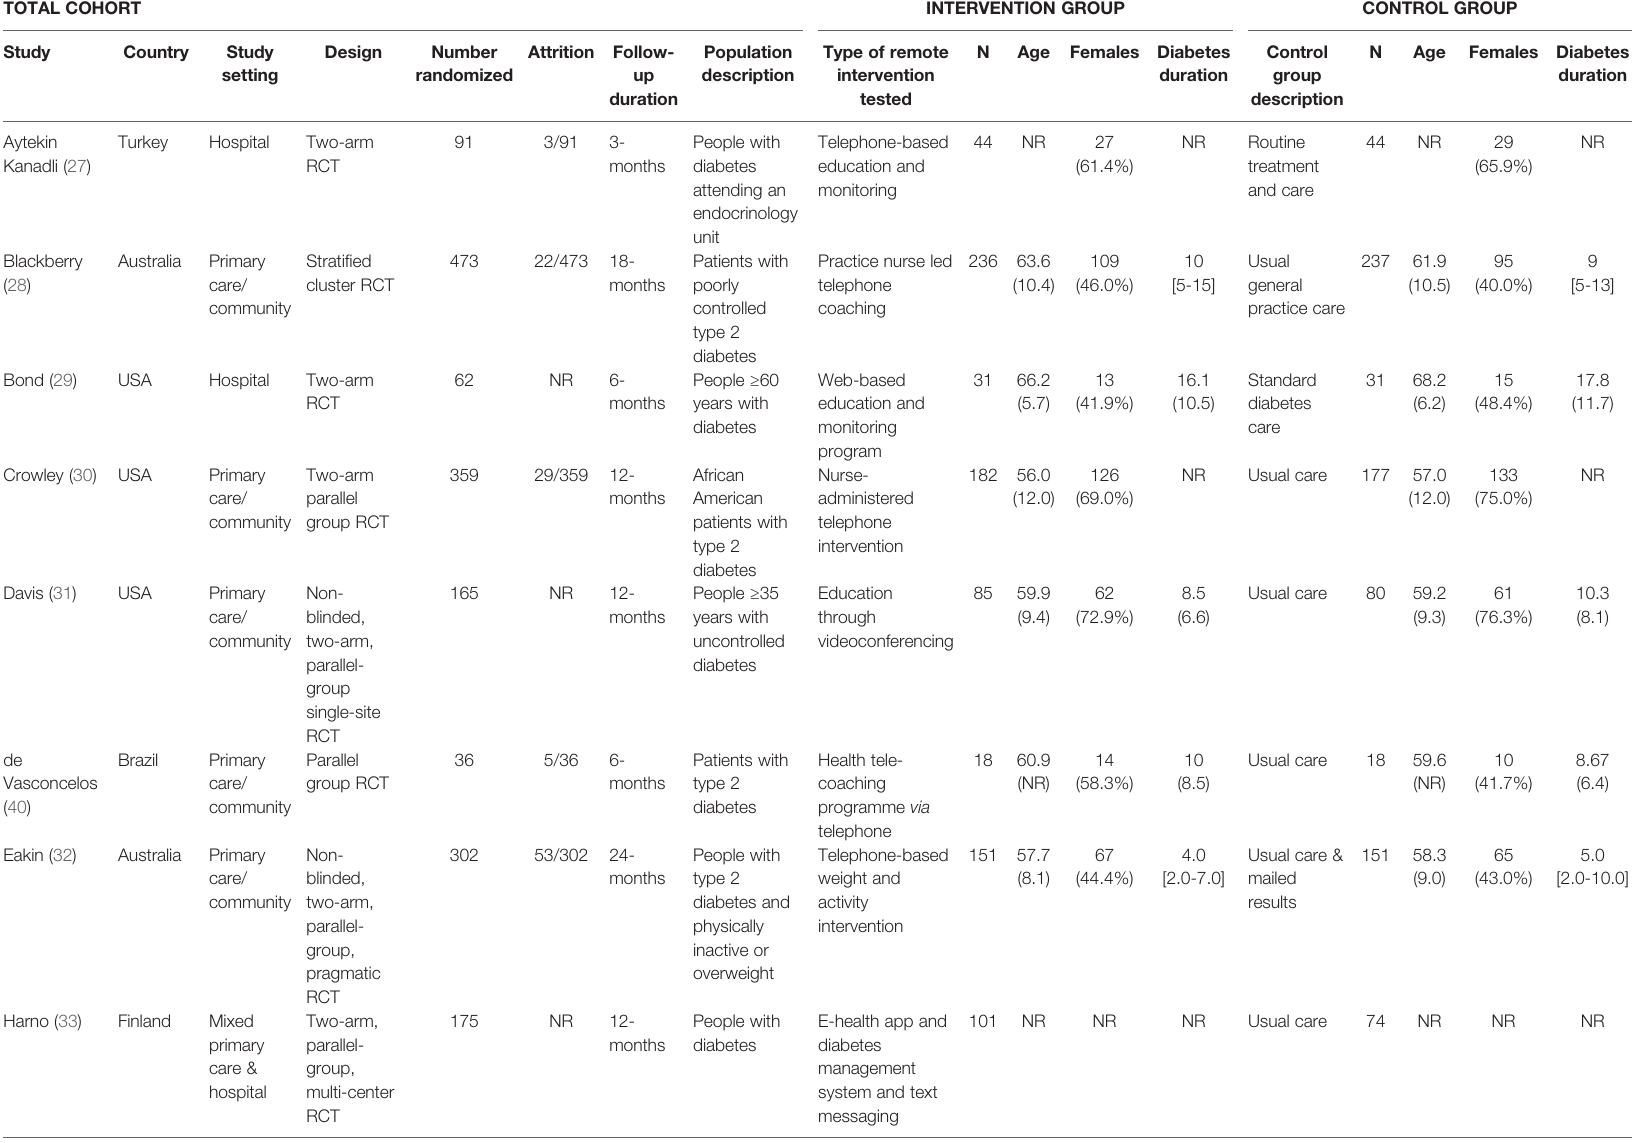
TABLE 1 | Characteristics of study participants in included randomized controlled trials